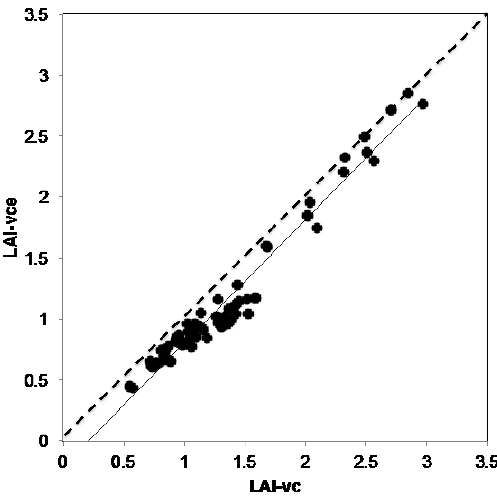
Figure 4. Relationship between plant area index (LAI-vc) and effective plant are index (LAIvc e = LAI × Ω(0 )) measured using the VitiCanopy App for three vineyards located in Langhorne Creek (SA), Hilltops (NSW) and Sunraysia (Vic) during the season 2013–14. The continuous line represents the calculated regression; the dashed line represents the 1:1 relationship.